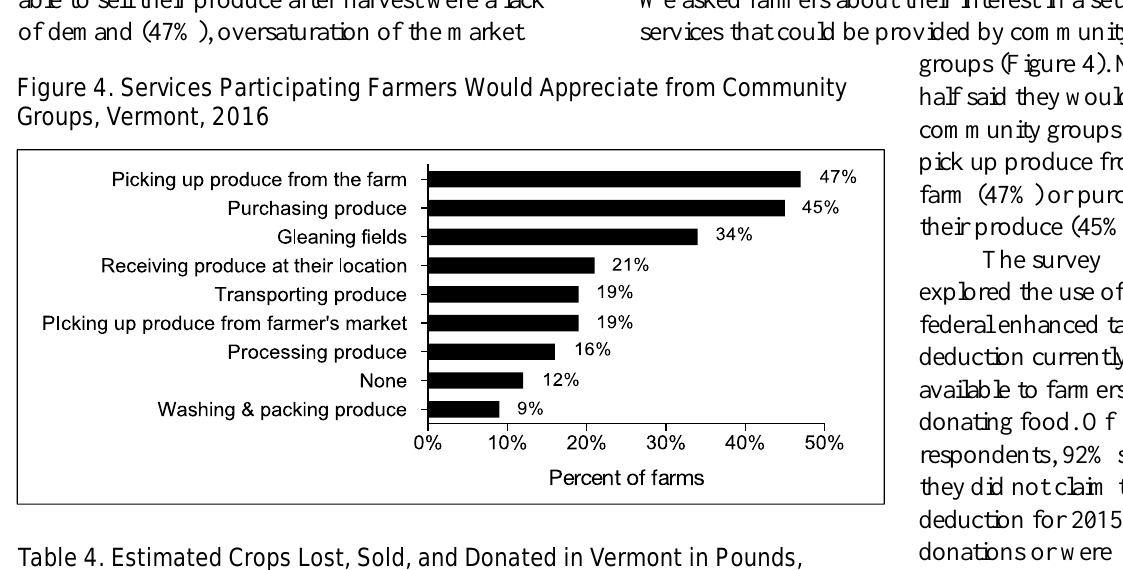
Table 4. Estimated Crops Lost, Sold, and Donated in Vermont in Pounds, Modeled Based on 2016 Survey